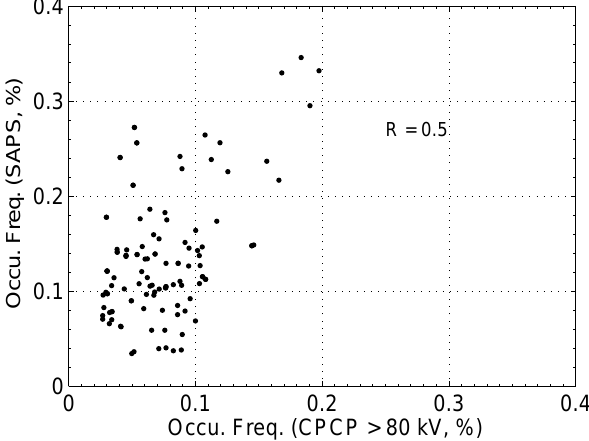
Fig. 4. Same as Fig. 1, but for substorm occurrence rate. The color code shows the probability in percent for a substorm to occur during an